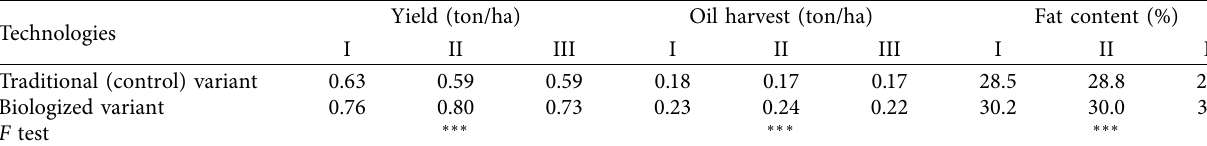
Table 4: Indicators of yield and quality of safflower depending on the cultivation technology in zone 1 of West Kazakhstan. Technologies